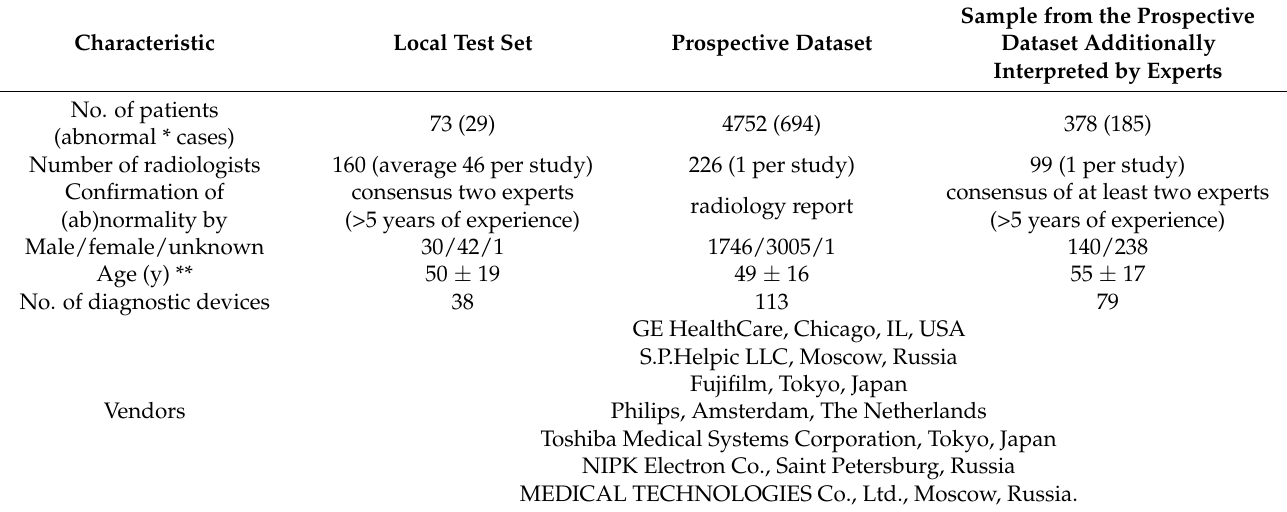
Table 1. Details on the retrospective local test set and prospective